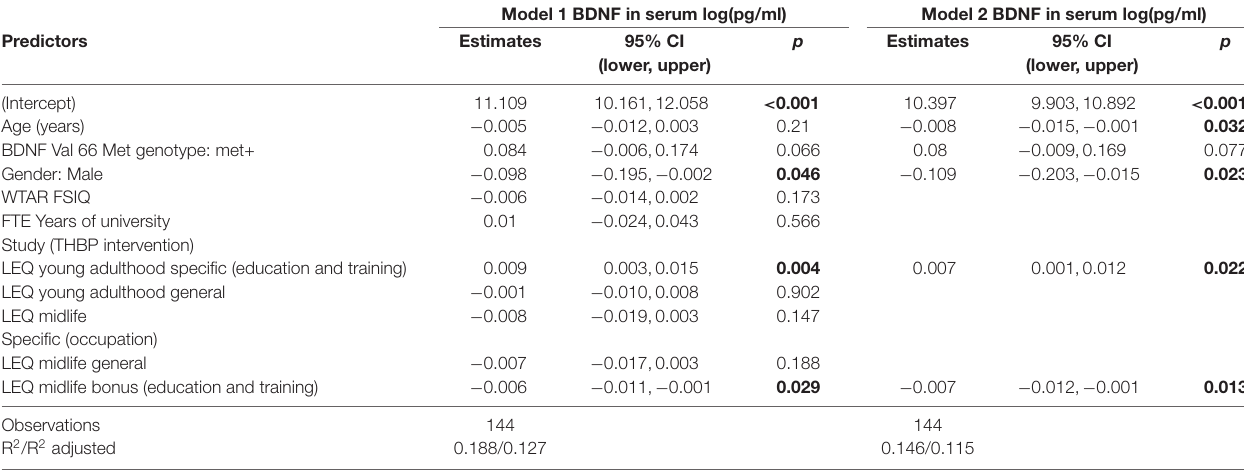
TABLE 2 | Linear regression coefficients with 95% confidence intervals for the associations between age, BDNF Val66Met genotype, gender, WTAR FSIQ, education and included LEQ variables on serum BDNF concentration log e (pg/ml).